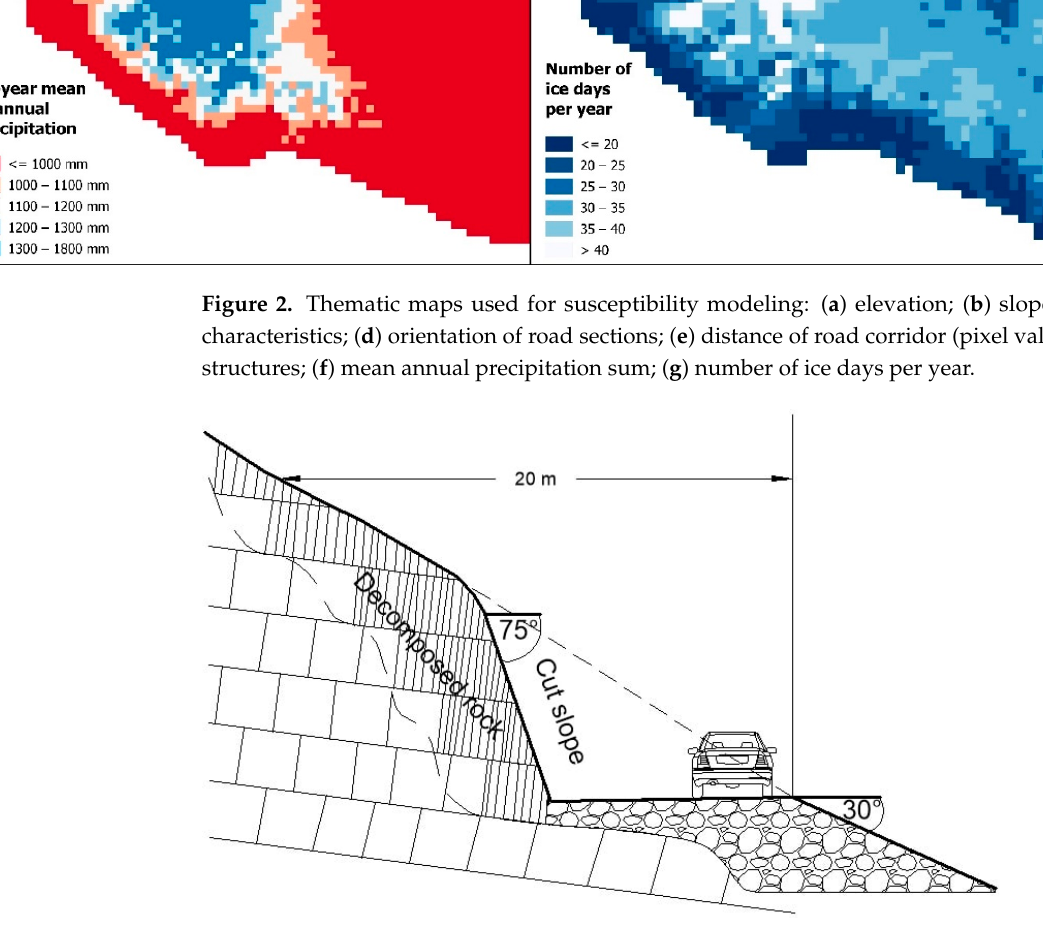
Figure 2. Thematic maps used for susceptibility modeling: ( a ) elevation; ( b ) slope; ( c ) material char- acteristics; ( d ) orientation of road sections; ( e ) distance of road corridor (pixel value) to tectonic structures; ( f ) mean annual precipitation sum; ( g ) number of ice days per year.